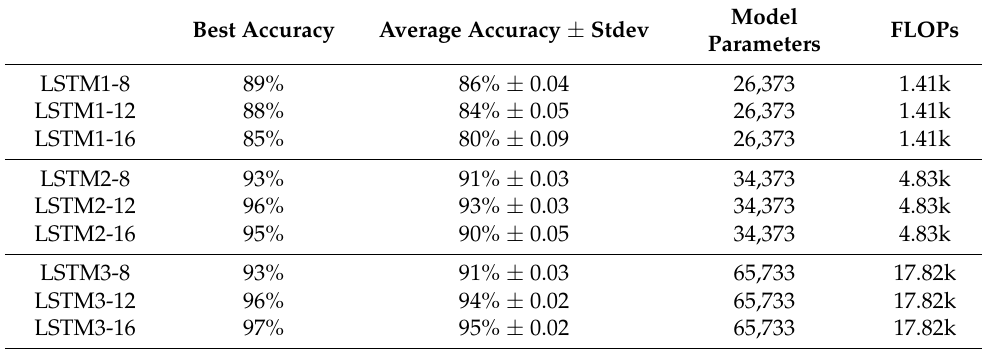
Table 2. Performance comparison of the proposed LSTM networks.